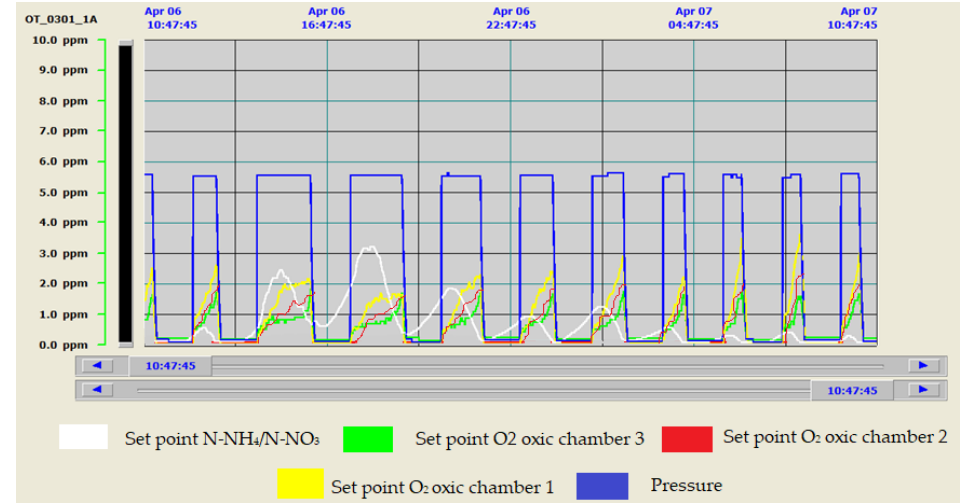
Figure 10. Evolution of Ammonium/Nitrate, oxygen in the three oxygen chambers and working pressure.